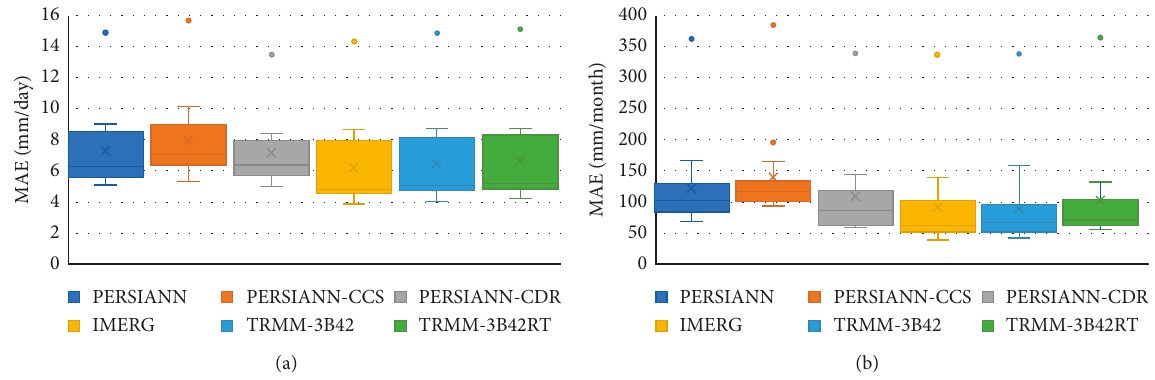
Figure 6: Results obtained from the MAE index. (a) For Daily. (b) For Monthly.